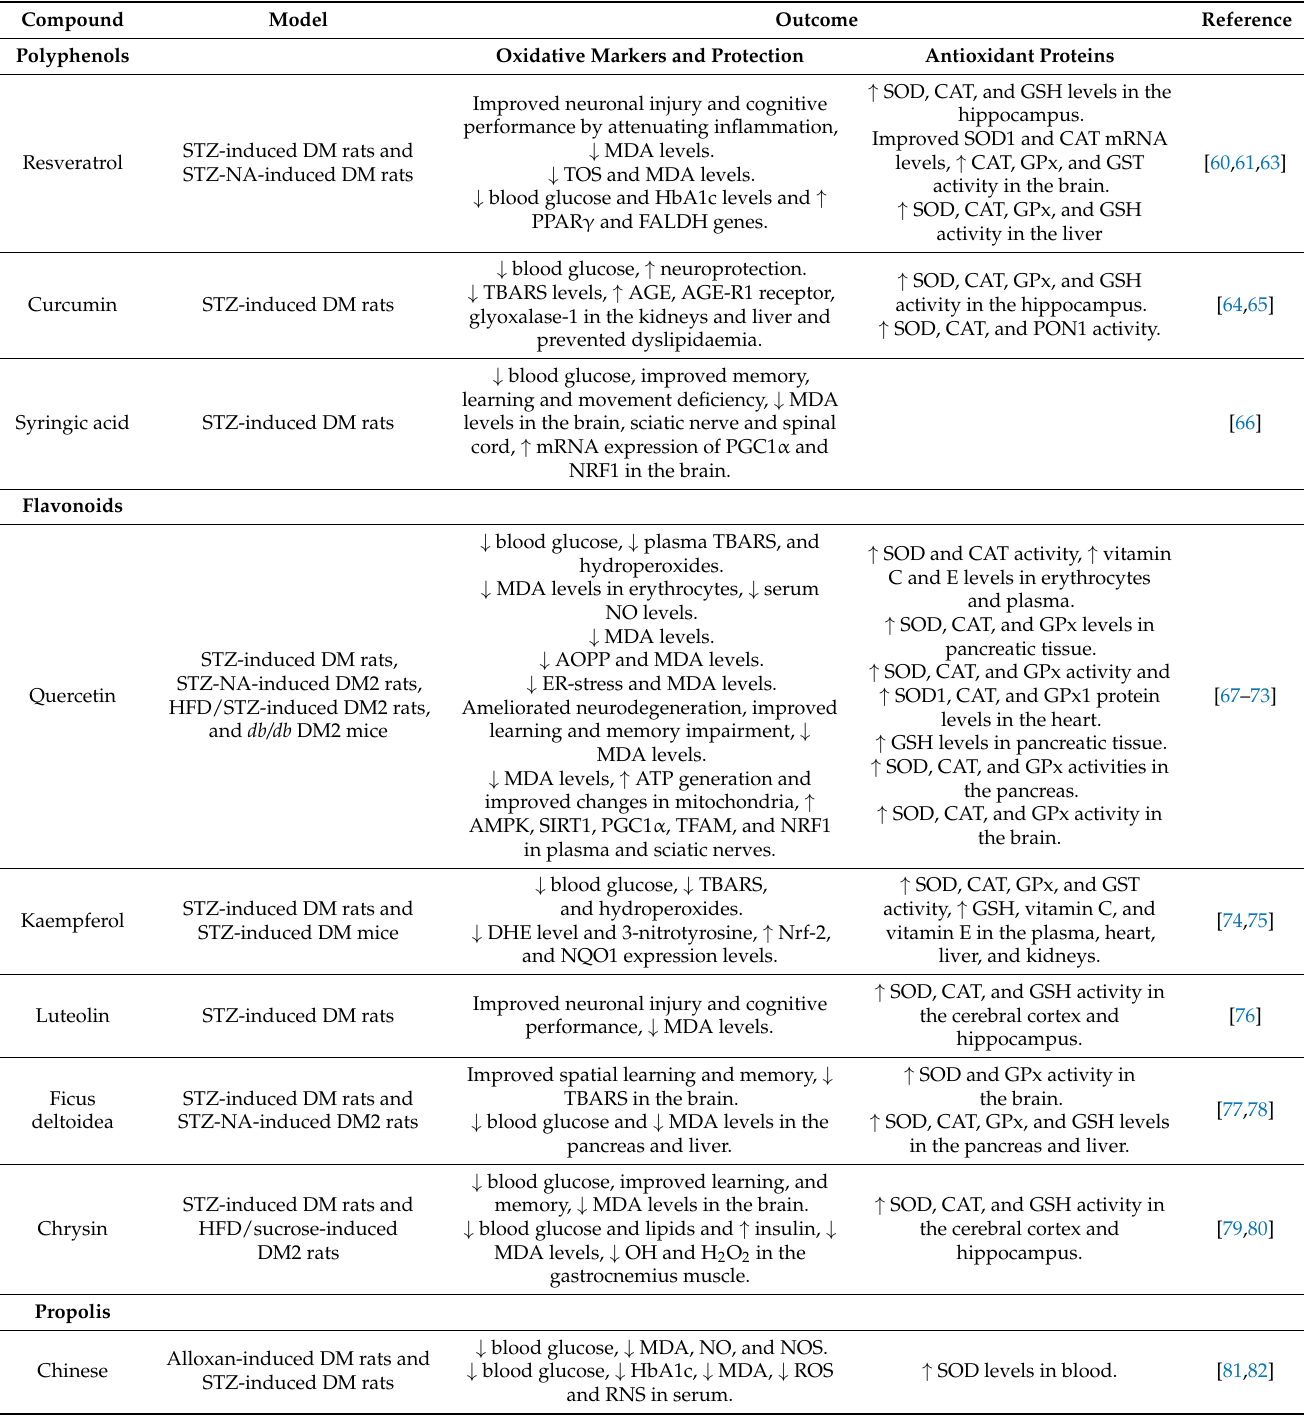
Table 1. The use of natural compounds as a strategy for counteracting oxidative stress in animal DM models. Compound Model Outcome Reference Polyphenols Oxidative Markers and Protection Antioxidant Proteins